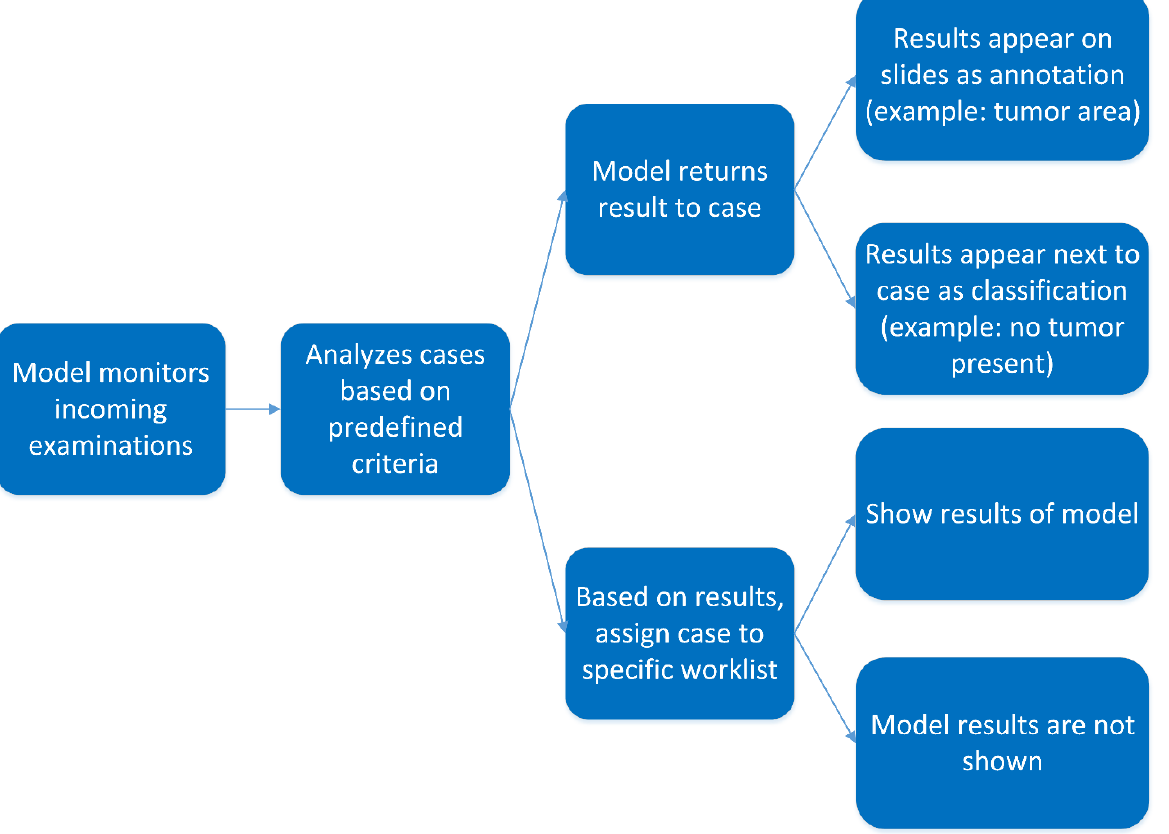
Figure 3. Flowchart showing workflow for background batch analysis, a workflow driven process.